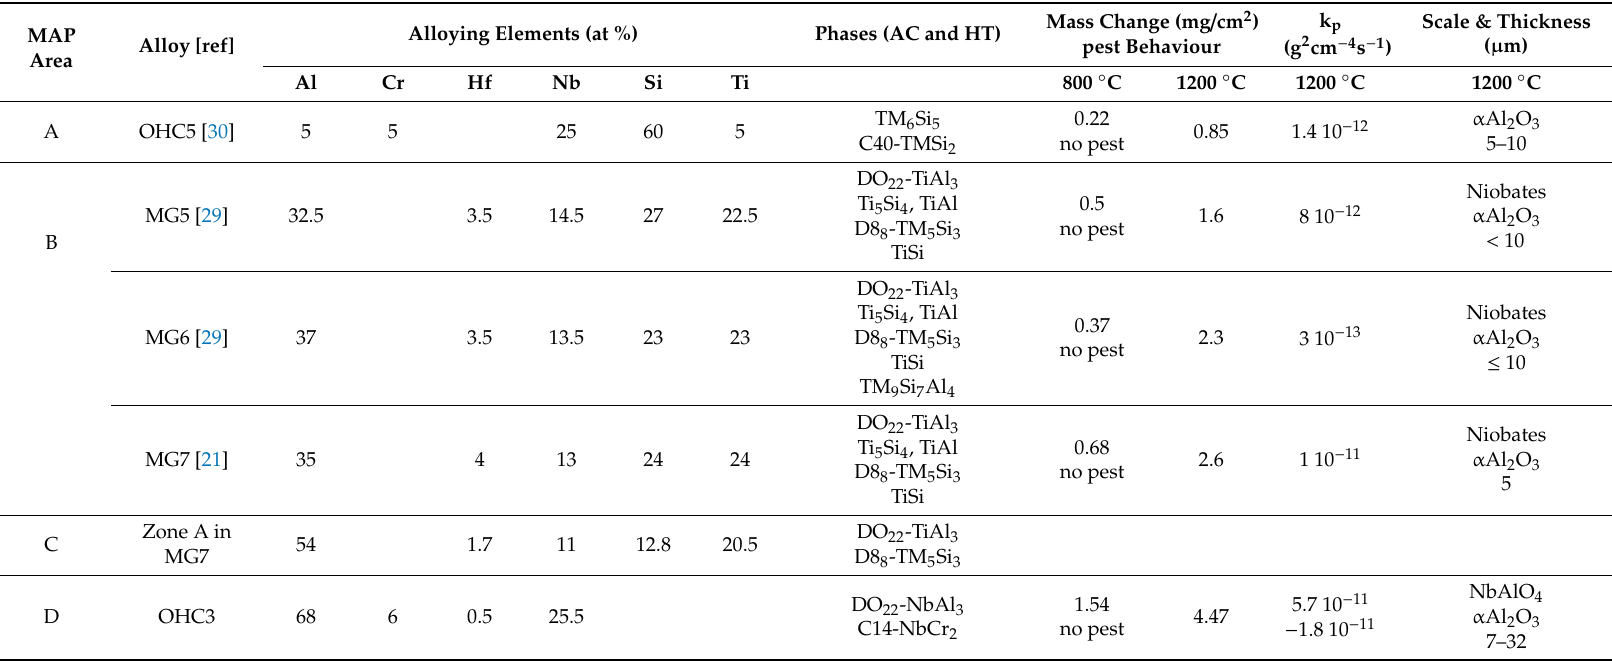
Table 2. Comparison of the alloys OHC3, OHC5, MG5, MG6, and MG7, see also Figure